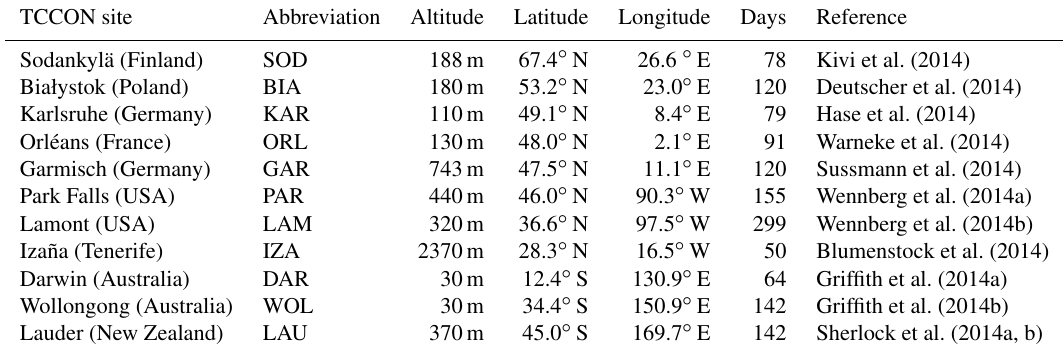
Table 2. Overview of TCCON measurement sites used for the evaluation of chemical transport models. Abbreviations of the site names, information about geographical location, and number of measurement days in 2010 are